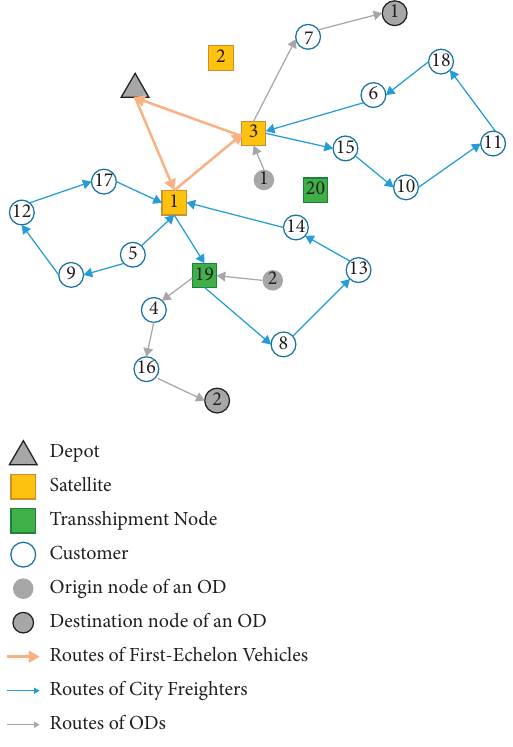
Figure 1: An illustration of